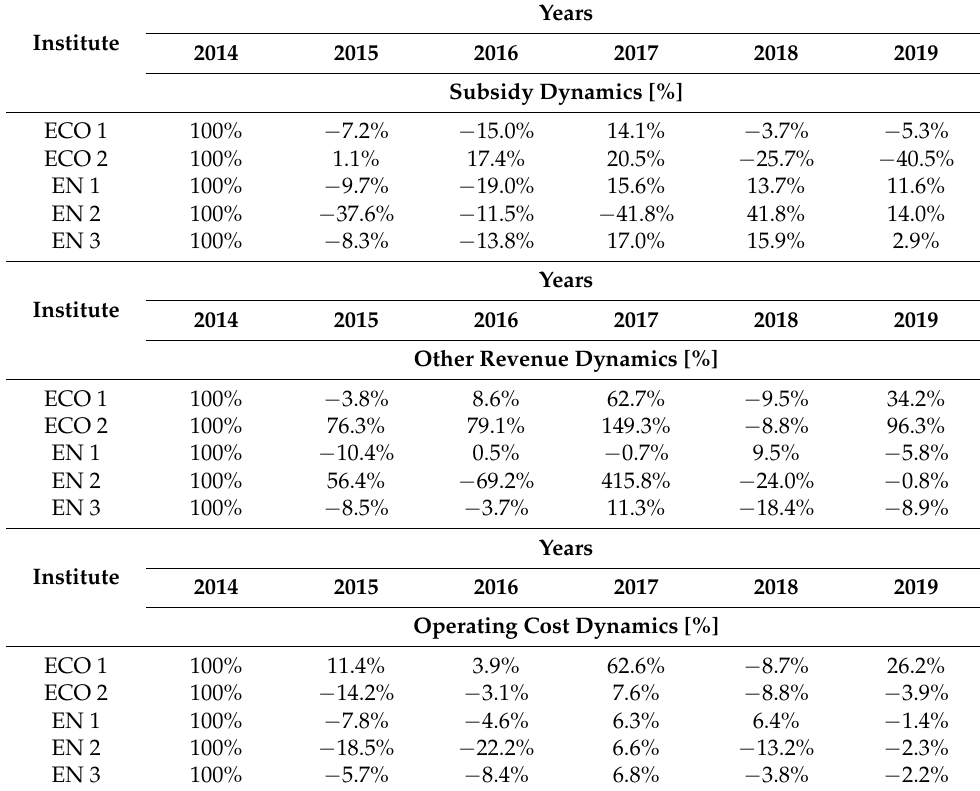
Table 3. Revenue and cost dynamics of the surveyed research institutes from 2014 to 2019 (year-on-year).